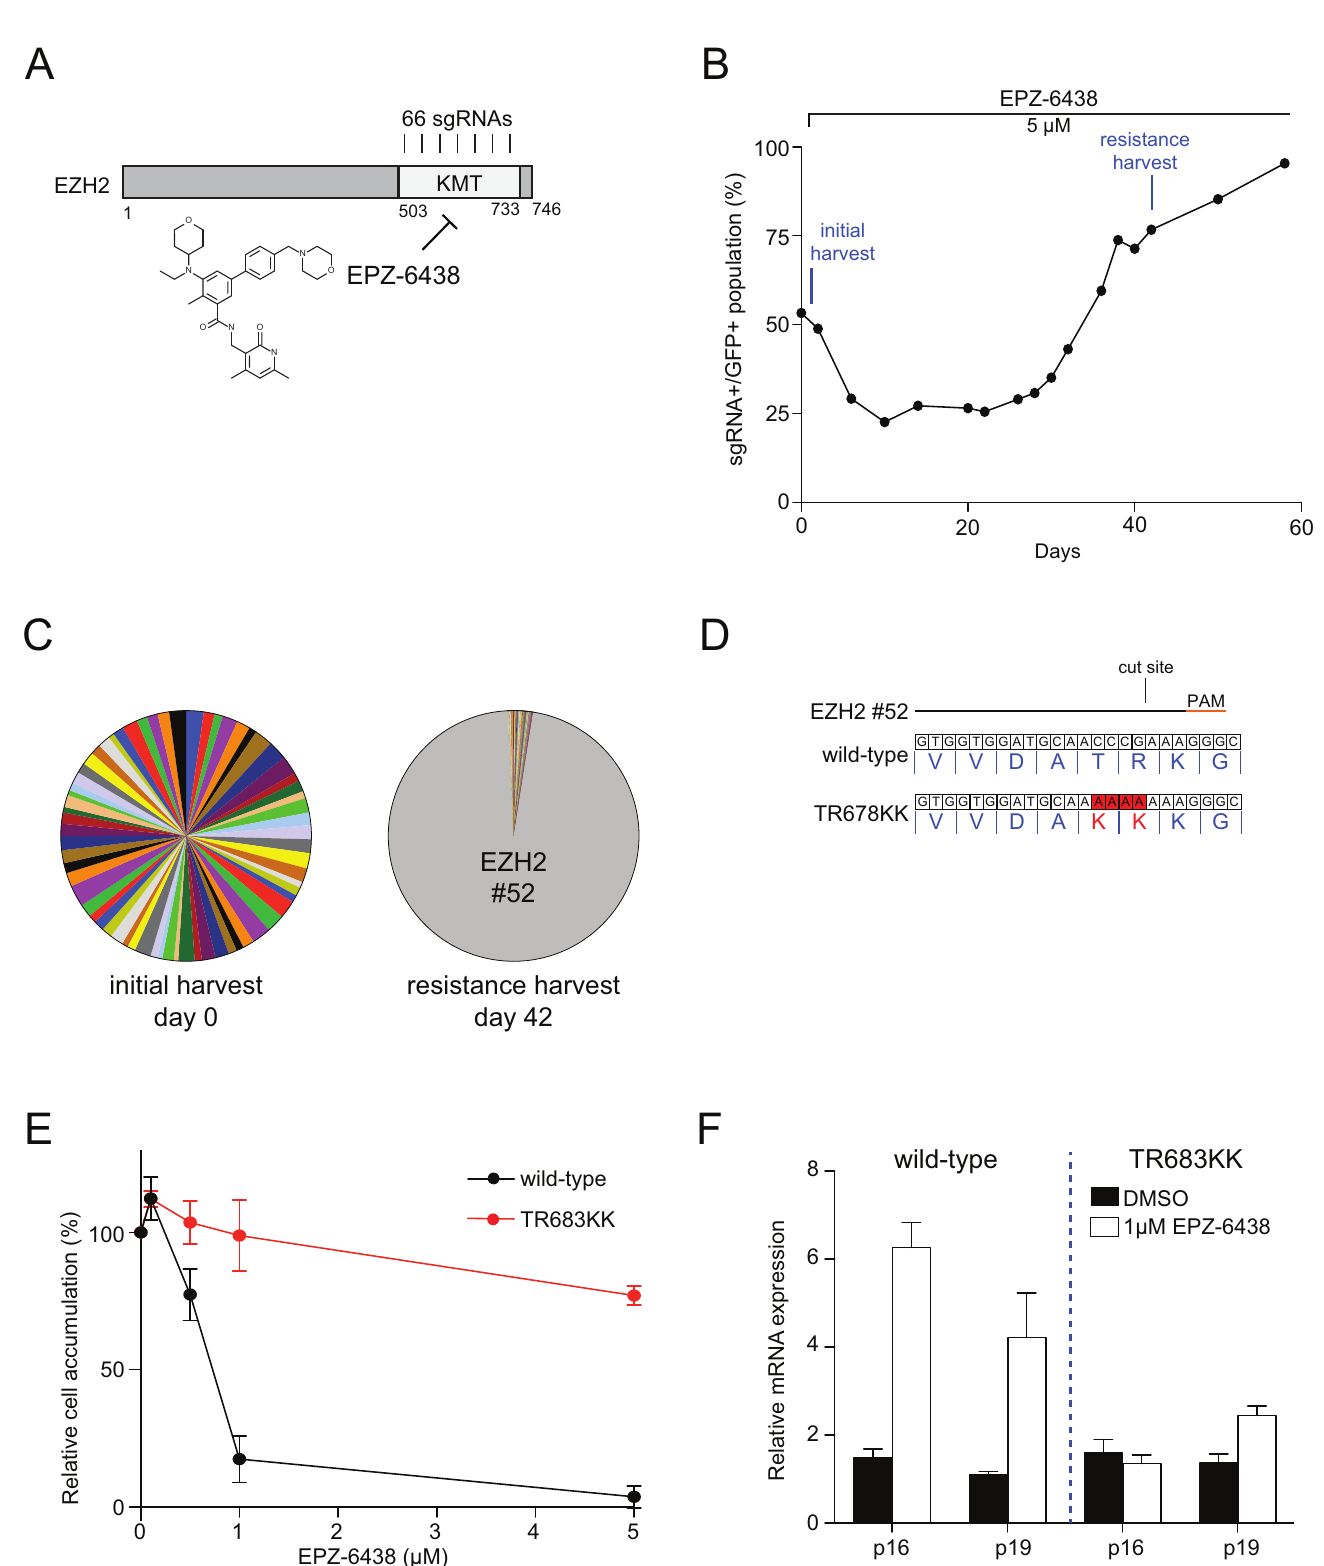
Fig 3. Domain-focused CRISPR genetic screening identifies an EZH2 mutant allele that is resistant to the drug EPZ-6438. ( A ) Schematic of EZH2 protein domain.A library of 66 sgRNAs was designedtargeting the KMT domainof EZH2. The EZH2 inhibitorEPZ-6438 inhibits the KMT function. ( B ) CRISPR indel mutagenesis genetic screeningidentifiedEZH2 mutants resistant to EPZ-6438 treatment. RN2c cells were treated with